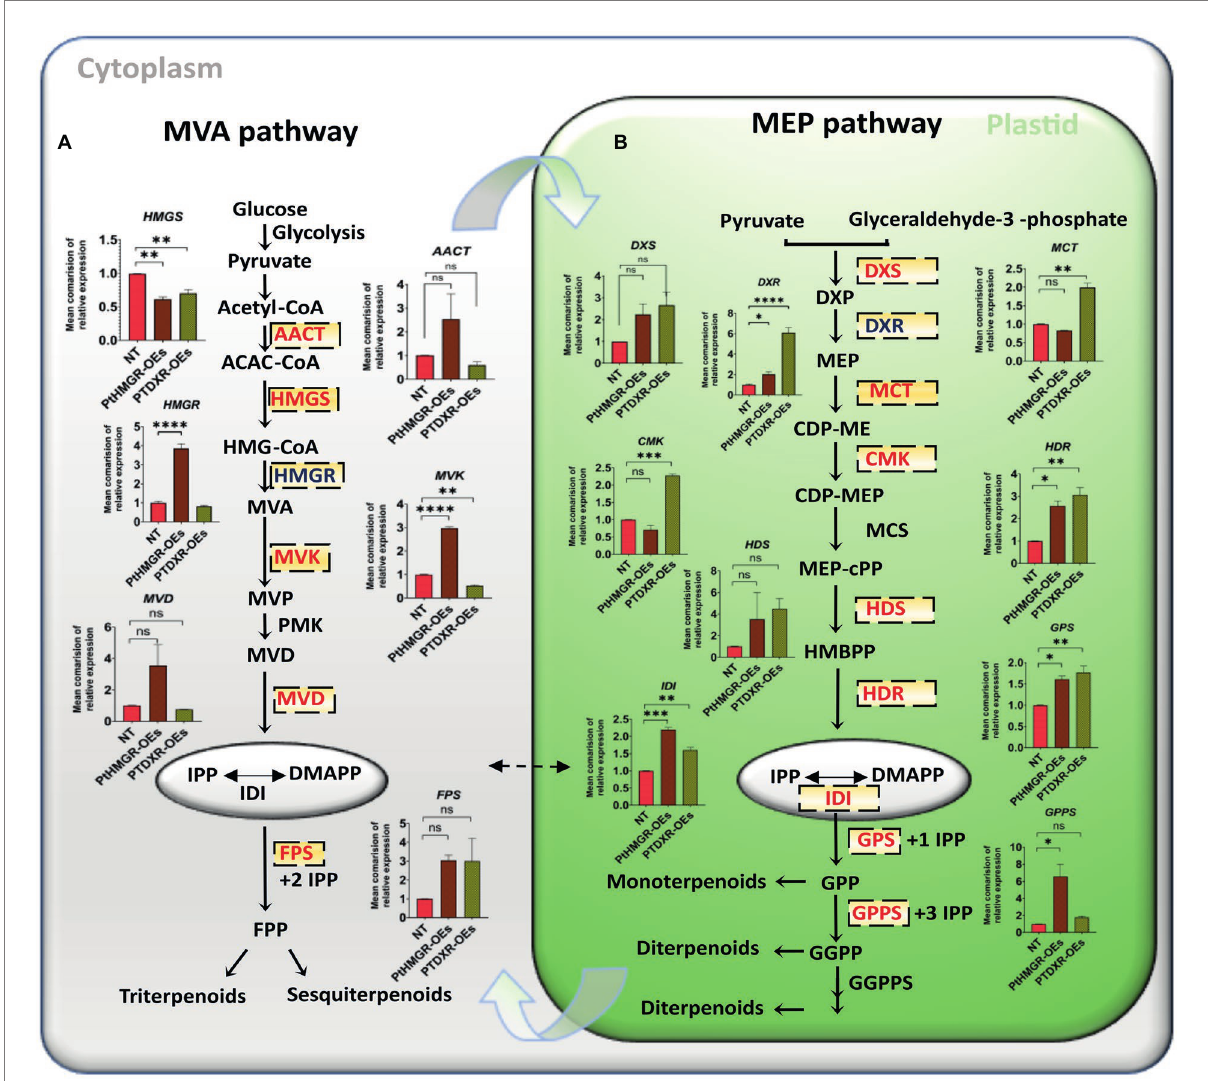
FIGURE 1 MVA and MEP-related gene expression analyses in PtHMGR-and PtDXR-OEs poplars. (A) Mean comparison of relative expressions of MVA related genes affected by PtHMGR-and PtDXR-OEs. (B) Mean comparison of relative expressions of MEP related genes affected by PtHMGR-and PtDXR- OEs; PtActin was used as an internal reference in all repeats; “ns” means not significant, * p < 0.05, ** p < 0.01, *** p < 0.001, **** p < 0.0001; Three independent replications were performed in each